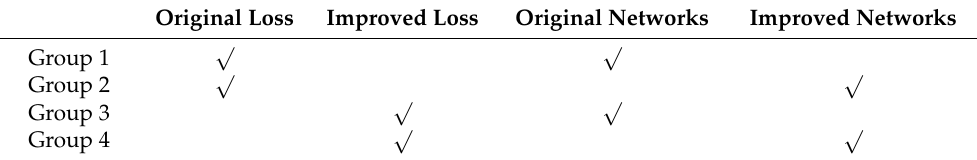
Table 2. Grouping experiments under different conditions.